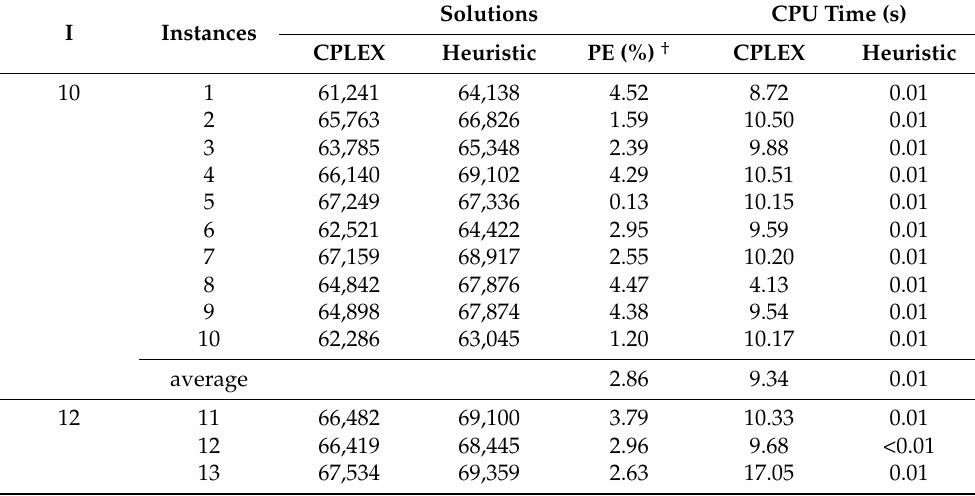
Table 1. Results of the test on 6-period